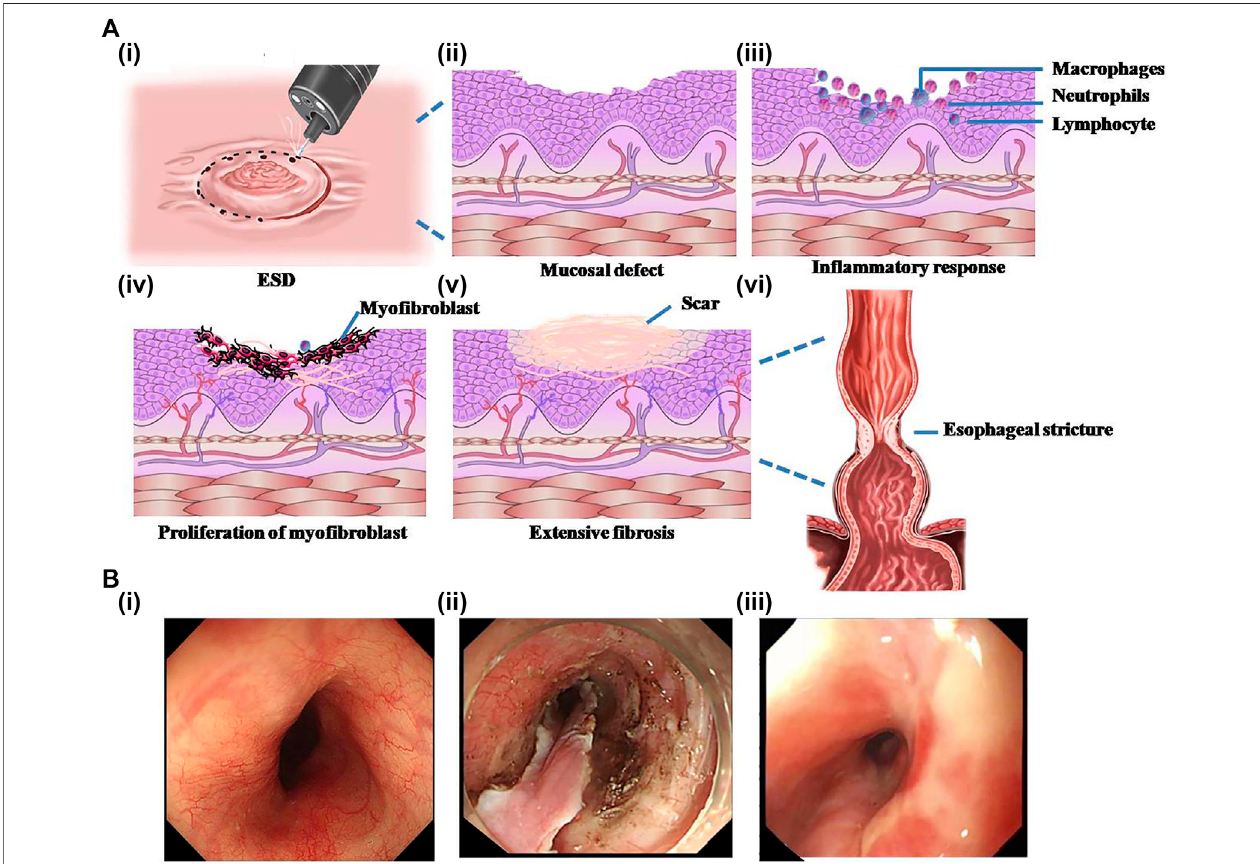
FIGURE 1 | Schematic representation of the formation process of esophageal stricture after endoscopic submucosal dissection (ESD) and the endoscopic photographs of esophageal stricture. (A) The schematic diagram of the formation of esophageal stricture. (i) ESD surgery. (ii) Irregular mucosal defect left after surgery. (iii) Acute in fl ammatory reaction in exposed mucosal wounds. (iv) Massive proliferation of myo fi broblasts after in fl ammation accompanied by angiogenesis in the submucosa. (v) Extensive fi brosisoftheesophagealmucosalwoundformingascar. (vi) Scarformationandcontractureatthewoundresultinesophagealstricture. (B) Endoscopic pictures of the esophagus. (i) Normal esophagus. (ii) Esophagus with mucosal layer stripped by ESD. (iii) Stricture-forming esophagus. Reproduced from Chu et al. (2019). Copyright (2019), with permission from Springer